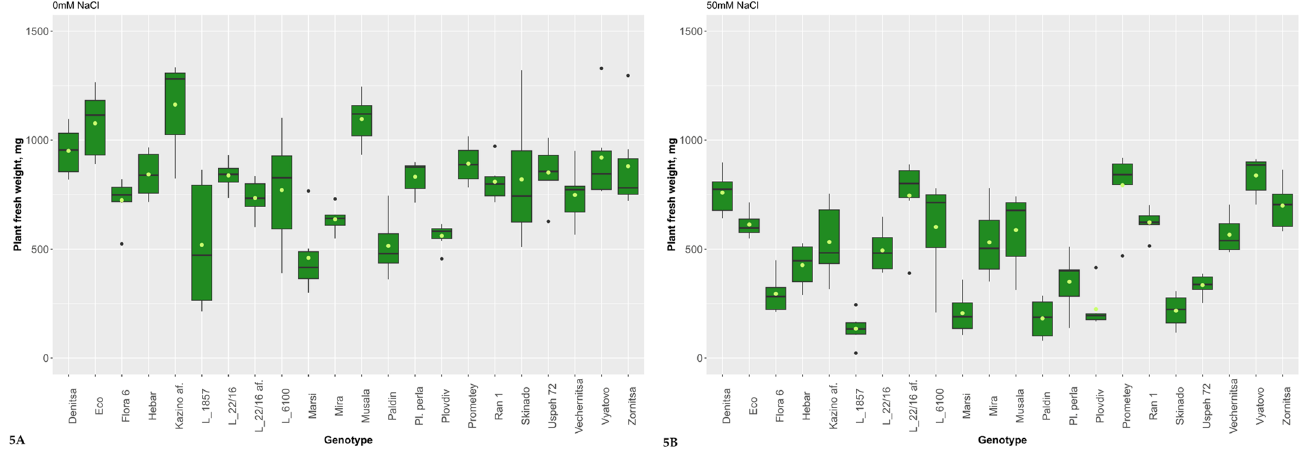
Figure 4. Root length (mm) of 22 garden pea genotypes as influenced by the concentration of NaCl in nutrient medium in vitro after 14 days of cultivation. ( A ) 0 mM NaCl; ( B ) 50 mM NaCl; ( C ) 100 mM NaCl; ( D ) 200 mM NaCl.